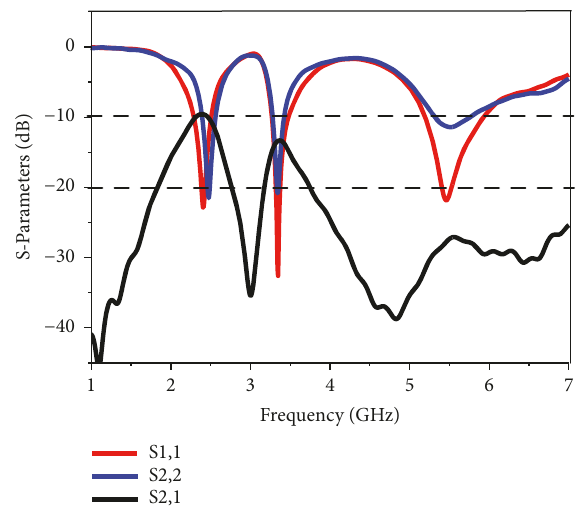
Figure 9: Simulated S parameters for the antenna array of case II.